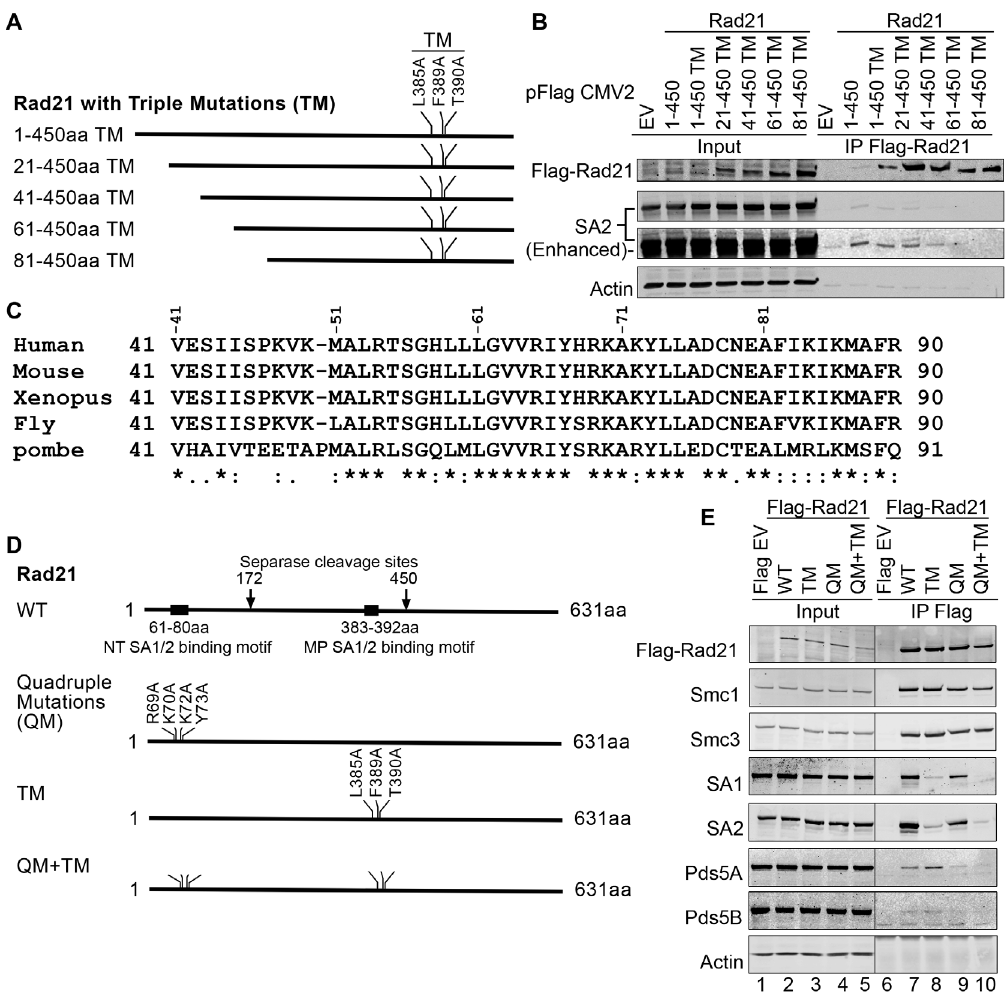
Figure 6. Identification of SA-binding site on N-terminus of Rad21. ( A ) Schematic illustration shows the N-terminal truncated mutants of Rad21 (1–450 aa) with triple mutations (TM) on middle part of SA-binding motif. The cDNA was cloned into pFlag CMV2 vector. ( B ) Immunoblotting of SA2 co-IP by Rad21 (1–450 aa) WT and mutants. 293 T cells were transfected with the constructs shown in (A) and IP was performed 40 h after transfection. Deleting the first 80 aa of Rad21 (1–450 aa) TM inhibits the co-IP of SA2. The second and third panels are from the same blot. The third panel was enhanced for better visualization. ( C ) Clustal format alignment of Rand21 (41–90 aa) by MAFFT L-INS-i (v7.015b). The bottom line shows the conserved amino acids from fission yeast ( S . pombe ) to human Rad21. Invariant, conserved, and semi-conserved residues are indicated by an asterisk (*), colon (:), and period (.), respectively. ( D ) Schematic illustration shows the full length Rad21 and the mutations on the two SA-binding motifs located on the NT and MP of Rad21, respectively. The cDNAs of Rad21 WT and mutants with quadruple mutations (QM) on the NT SA-binding motif and/or triple mutations (TM) on the MP SA-binding motif were cloned into pFlag CMV2 vector. ( E ) Immunoblotting of co-IP of cohesin subunits by Rad21 WT or mutants. The dividing lines indicate that interfering lanes have been spliced